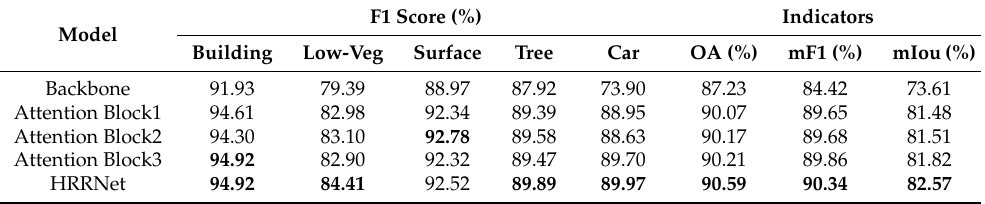
Table 1. Ablation results of the first set (on Vaihingen data set), the optimal results are bolded.